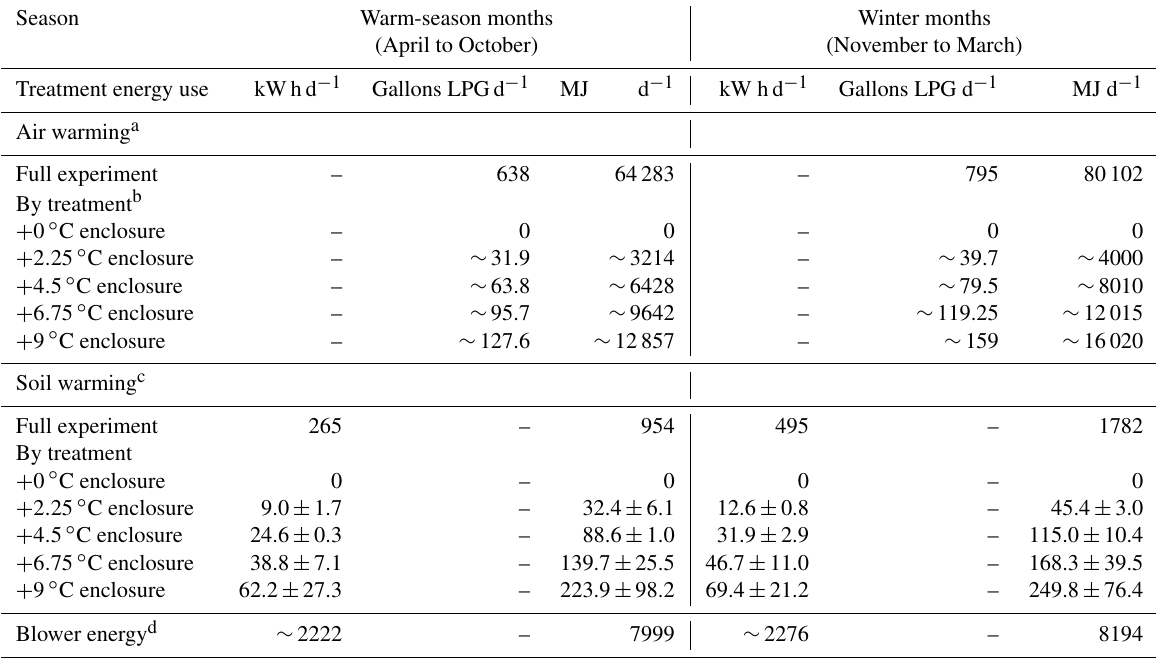
Table 5. Daily energy requirements for air and soil warming for the overall experiment and values for individual treatment plots.